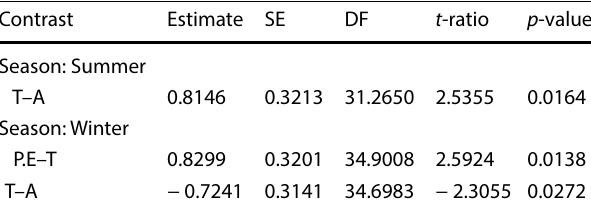
Table 9 Welch two-sample t -tests of treatment processes with une- qual sample variances within seasons Contrast Estimate SE DF t -ratio p